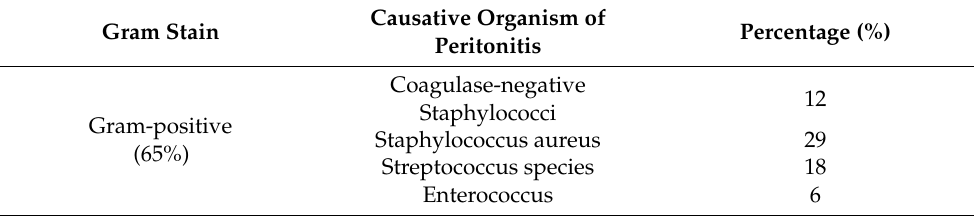
Table 2. Causative organisms of